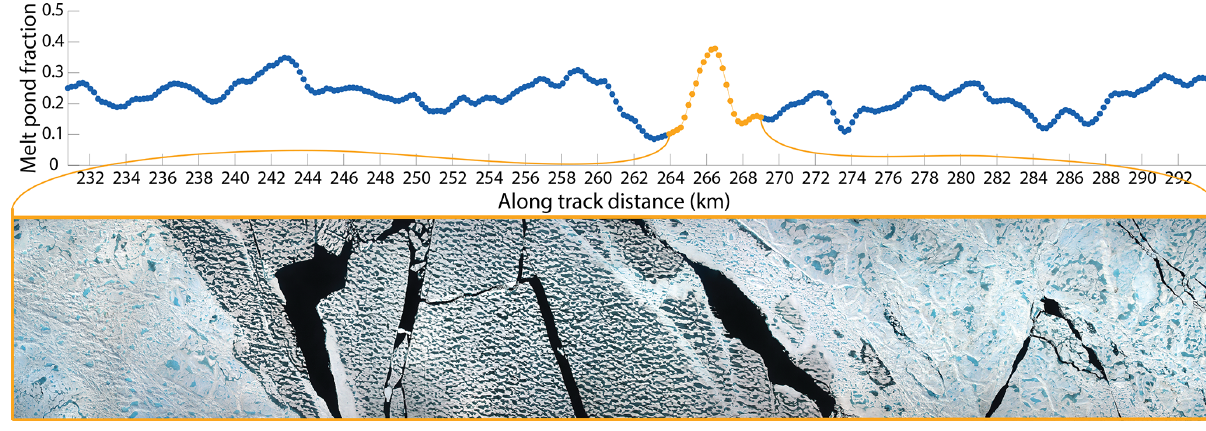
Figure 6. Melt pond fraction along a several-kilometer section of the 24 July 2017 flight. The orange highlighted region is depicted as a series of stitched together DMS images that show a first-year inclusion between two multiyear